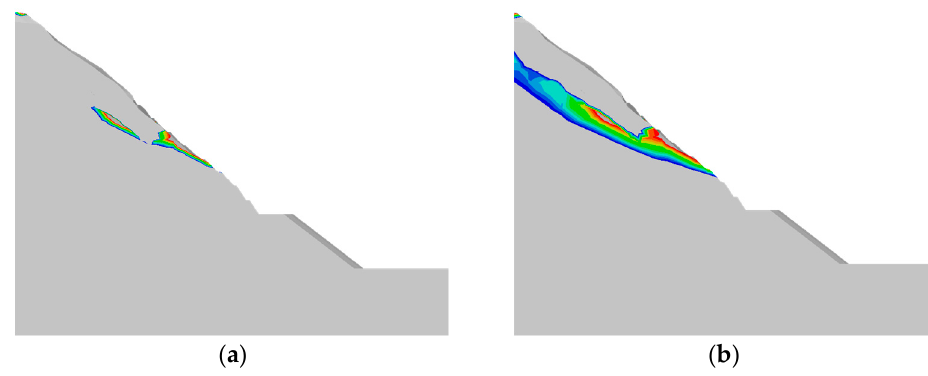
Figure 15. Development process of shear strain rate concentration area. ( a ) Distribution of plastic zone in slope during early rainfall. ( b ) Distribution of plastic zone in slope at the end of rainfall.